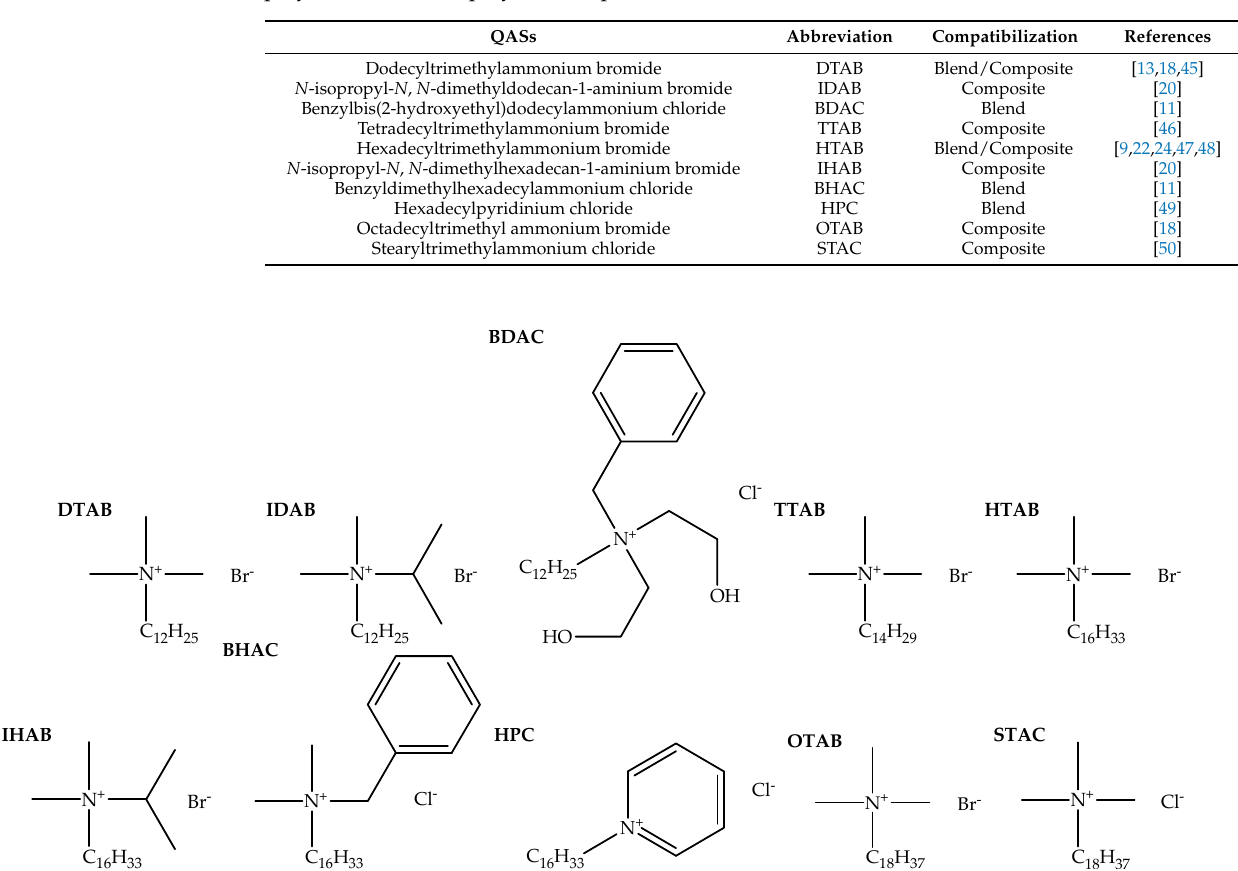
Figure 5. Chemical structures of QASs and the abbreviations are explained in Table 5.